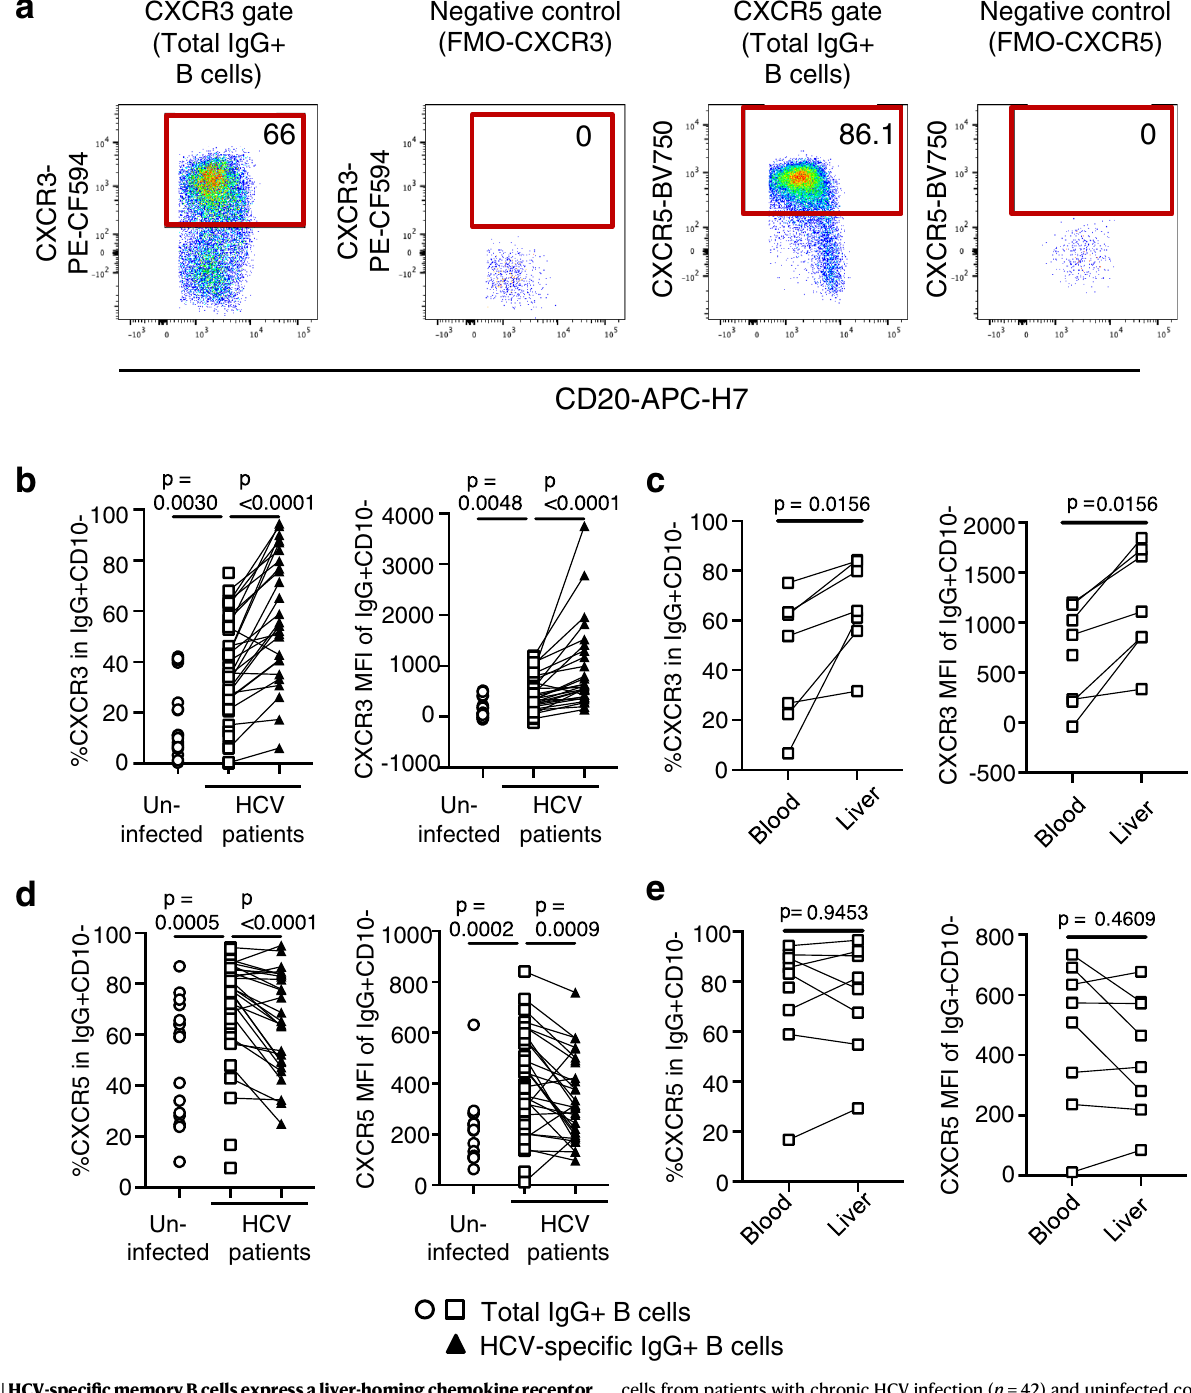
cells from patients with chronic HCV infection ( n =42) and uninfected controls panel). Two-sided p values were calculated with the Wilcoxon signed-rank test for paired data and the Mann – Whitney U -test for unpaired data. Each data